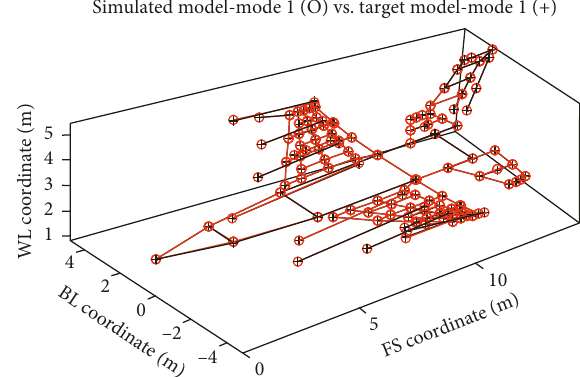
Figure 33: Mode shape for configuration 1